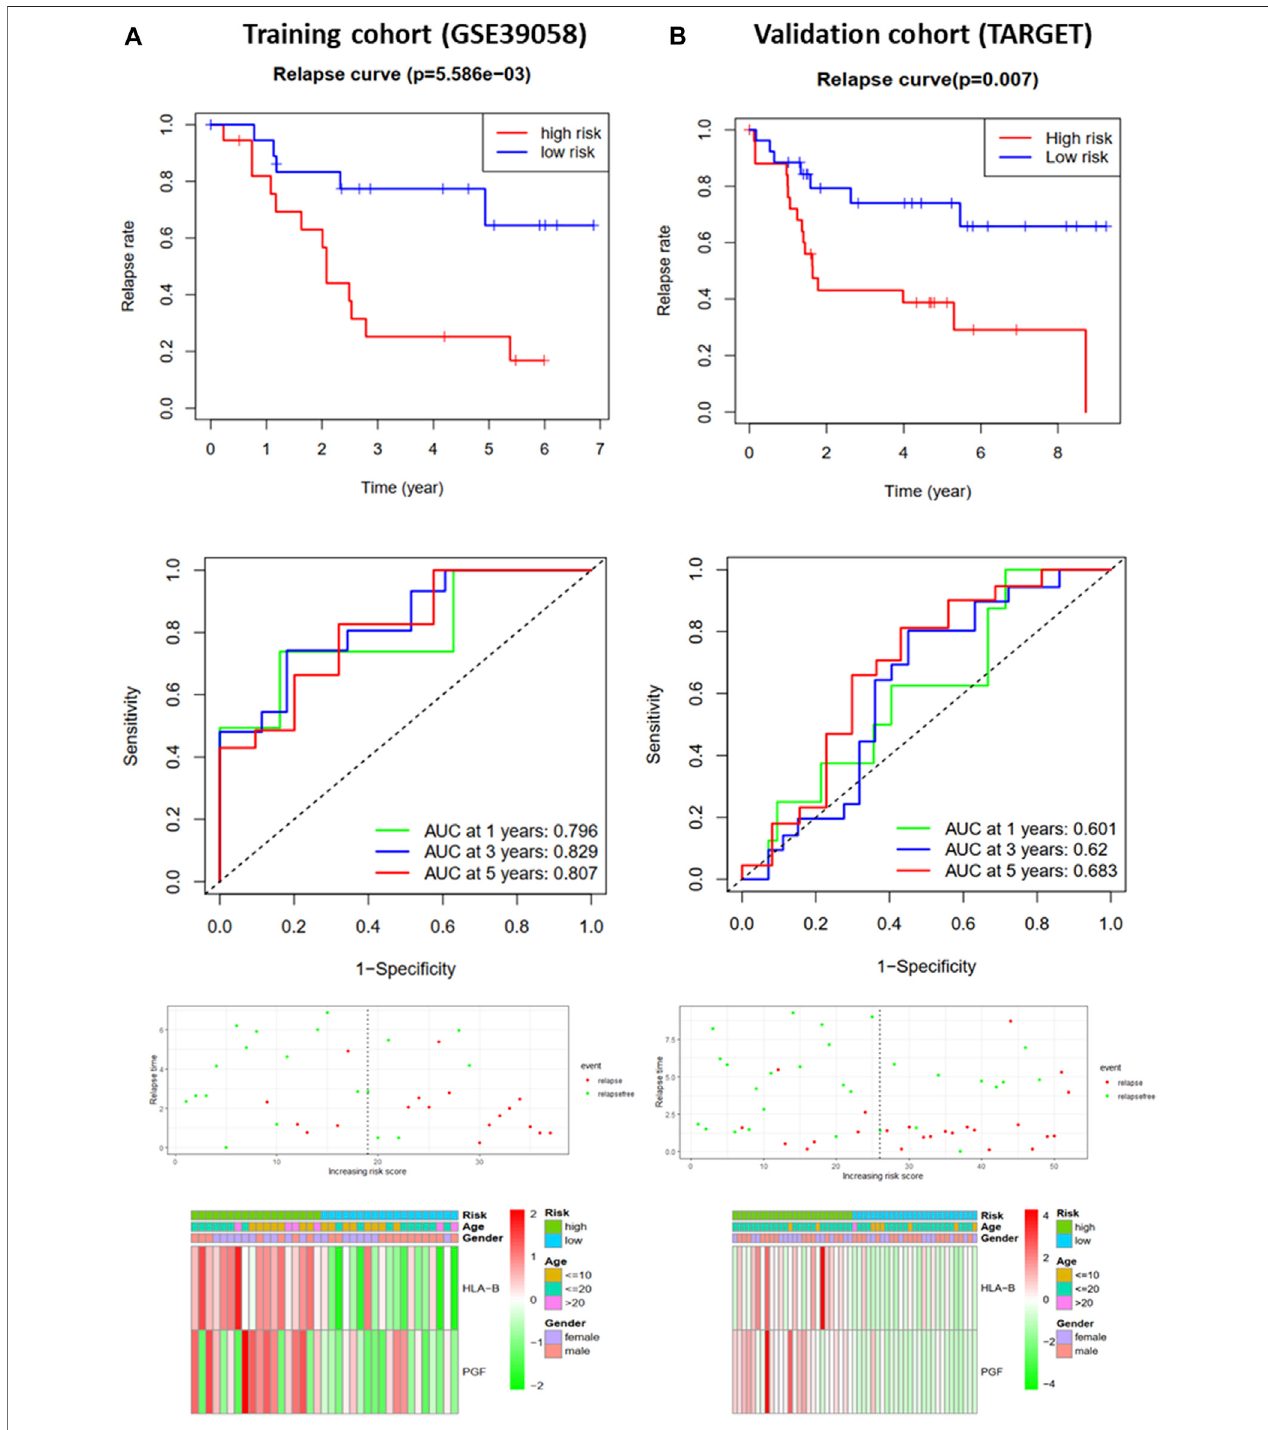
FIGURE 4 | Development and validation of the RFS-prediction model for osteosarcoma. (A) Relapse curve, ROC curve, relapse status, and heatmap for low- and high-risk subgroups in training cohort (GSE39058). (B) Relapse curve, ROC curve, relapse status, and heat map for low- and high-risk subgroups in validation cohort